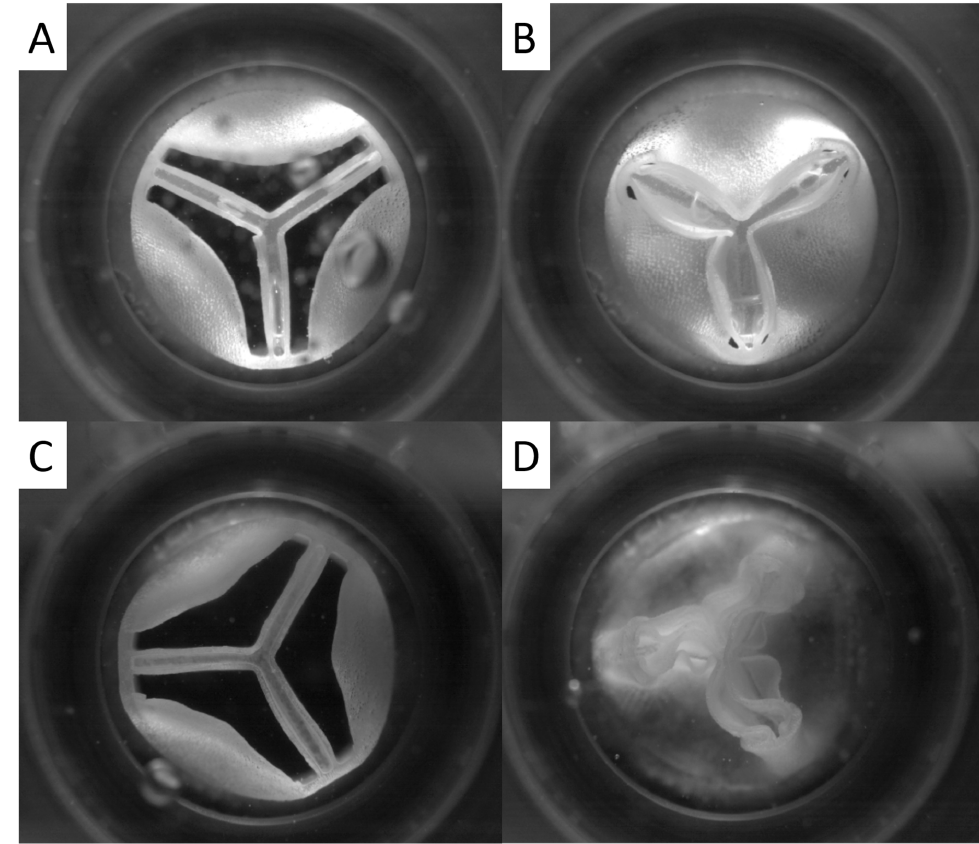
Figure 4. Images of prototype C5 built from silicone with Shore hardness 65 ( A , B ) and 35 ( C , D ) in open and closed states during hemodynamic testing.